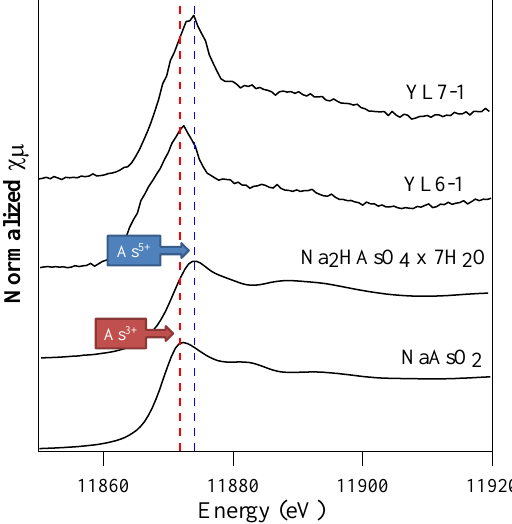
Fig. 6. Curve-fitting data of the Fe2p 3 / 2 core level. (a) 13m in YL6- 1, (b) 15m in YL6-1, (c) 8m in YL7-1, (d) 10m in YL7-1, (e) 14m in YL7-1, and (f) 21m in YL7-1. The solid line represents the experimental curve after smoothing and the dotted lines represent the fitted curve.